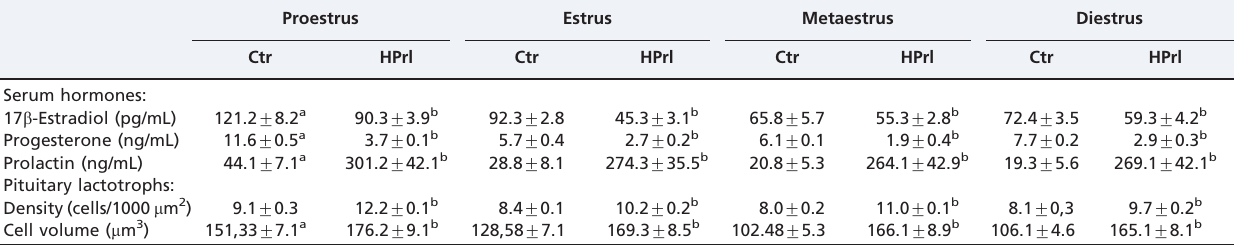
Table 1 - Circulating hormones and pituitary morphometric data throughout the estrous cycle in female control mice (Ctr) or mice rendered hyperprolactinemic (HPrl) by treatment with metoclopramide.